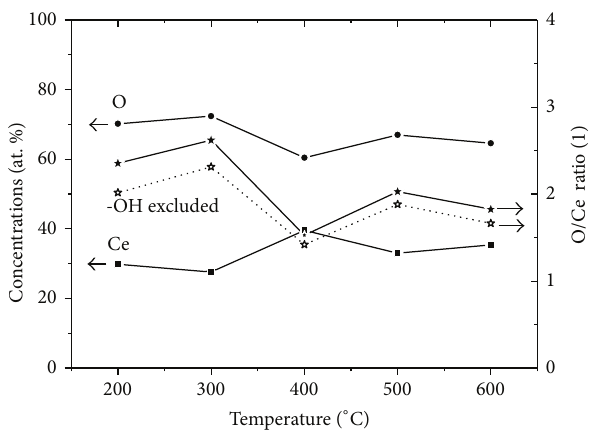
Figure 5: The concentration of cerium (by square) and oxygen (by circle) in the samples on left axis and O/Ce ratio with total oxygen (by full star—full line) and O/Ce ratio with only Ce bonded oxygen (by empty star—dot line) on right axis.